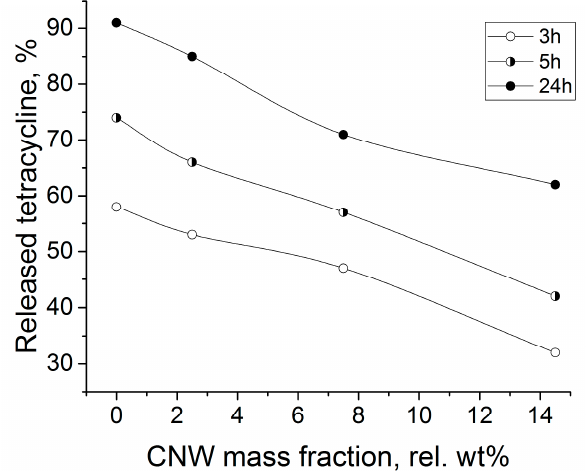
Figure 9. Dependence of the fraction of released tetracycline on the mass fraction of CNW at different release times.